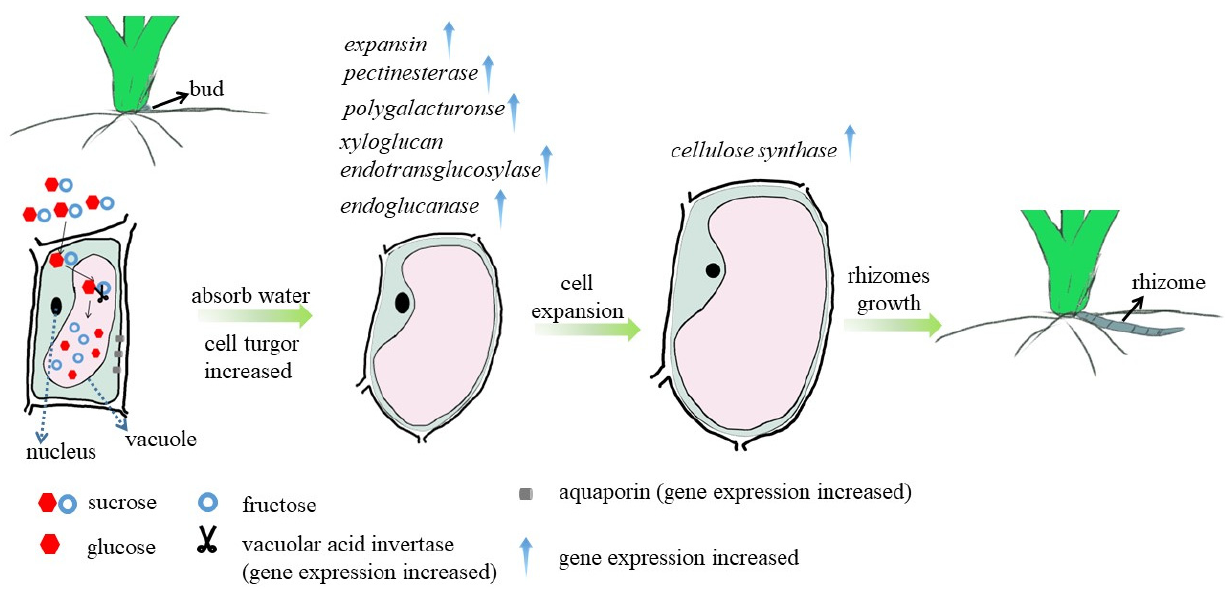
Figure 9. The regulatory mechanism of sucrose on rhizome elongation of Oryza longistaminata .